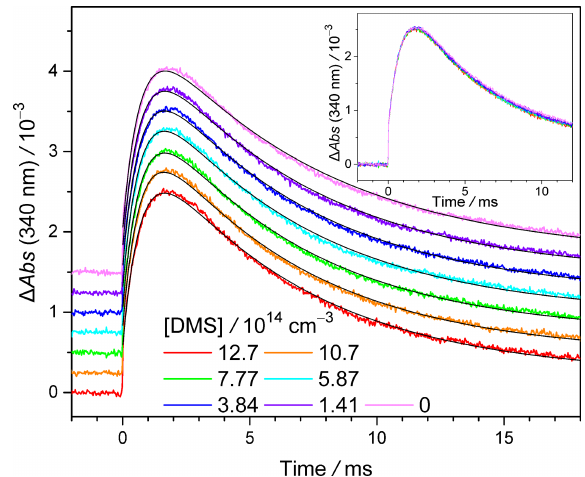
Figure 3. Representative MVKO absorbance–time profiles recorded at 340nm under various [DMS] values (298K, 300 Torr, see Exp#16 of Table S3). The profiles are upshifted by various amounts to avoid overlapping. The color lines are experimental data and the smooth black lines are the model fit. The inset shows the profiles without upshifting to show the overlapping.